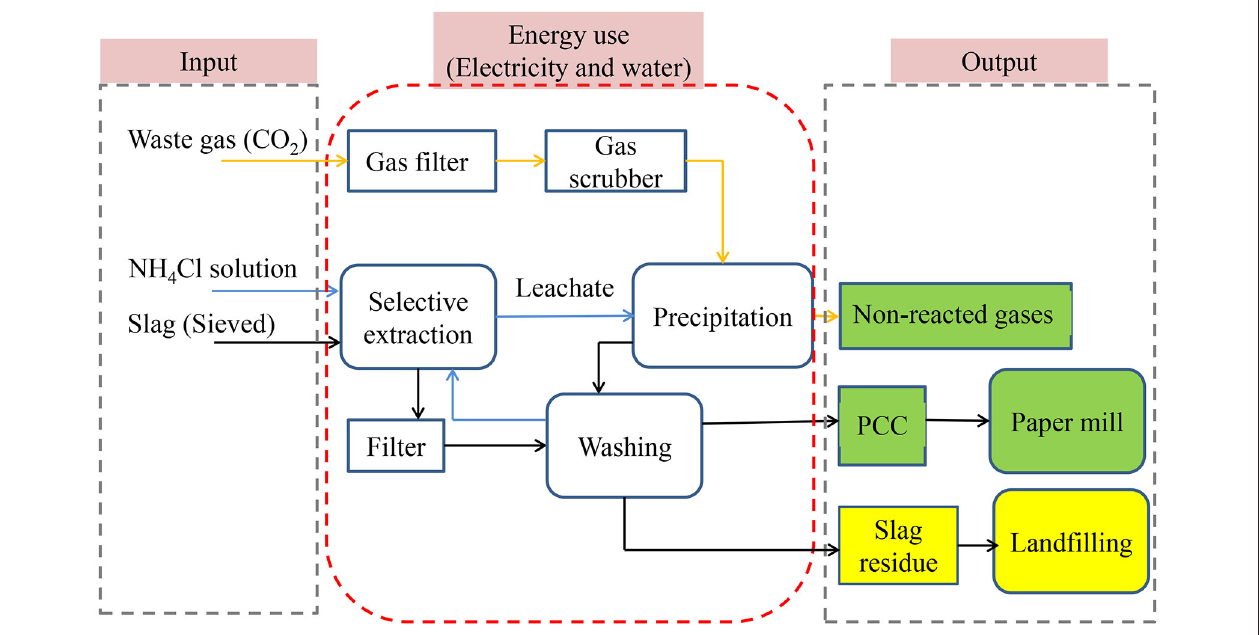
FIGURE 1 | The slag2PCC route for PCC manufacturing from steelmaking slags: gas streams are in yellow arrows, aqueous streams are in blue arrows, and solid streams are in black arrows. Output items that are beneficial to the environment and resources are green, and items that have potential effects on the environment and resources are